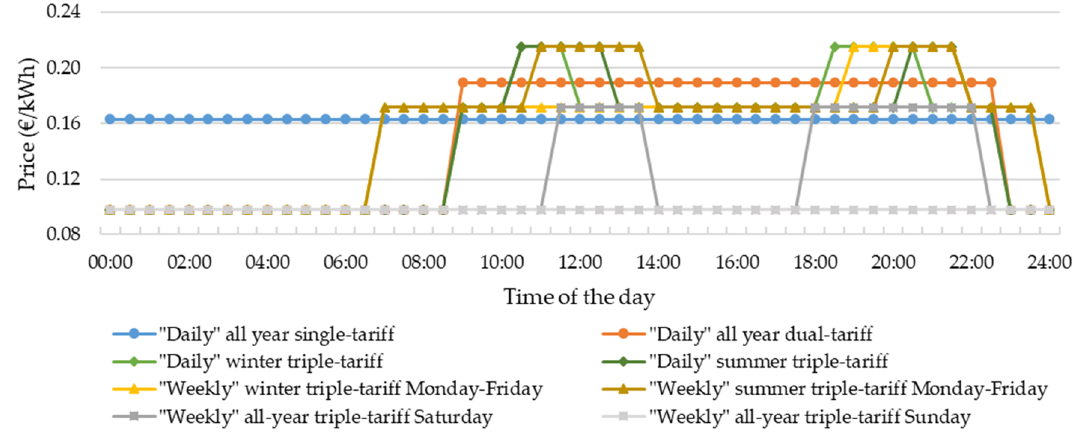
Figure 7. Time-of-use tariff options in Madeira, based on [43] (“Daily” indicating no difference between weekdays and “Weekly” indicating a difference between Monday-Friday, Saturday and Sunday).